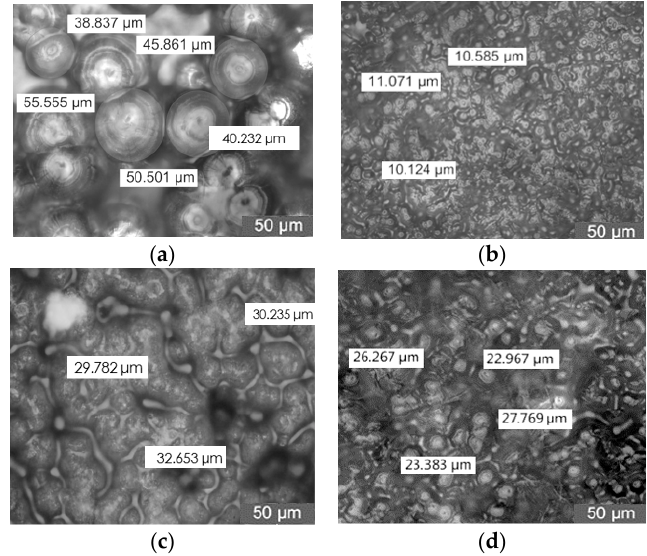
Figure 1. PLM patterns of the samples: ( a ) LDPE, ( b ) N3, ( c ) M3, ( d ) N3M2.